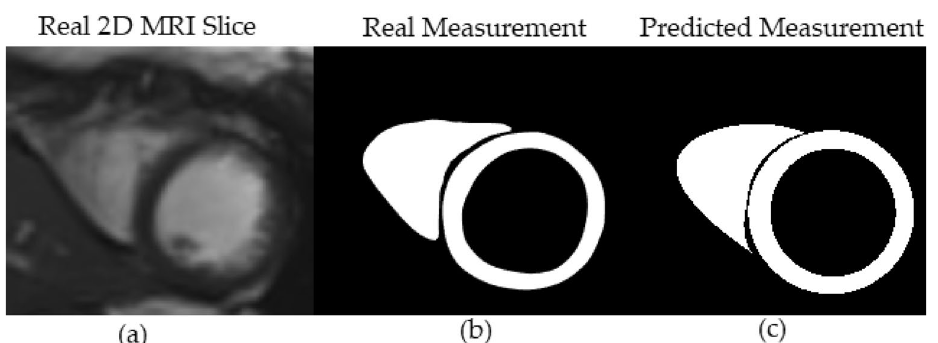
Figure 7. ( a ) The real cardiac MRI 2D image slice. ( b ) The segmented binary slice measurement z t . ( c ) The predicted binary measurement ˆ z t , generated from the contours obtained via the intersection of deformable model and image slice